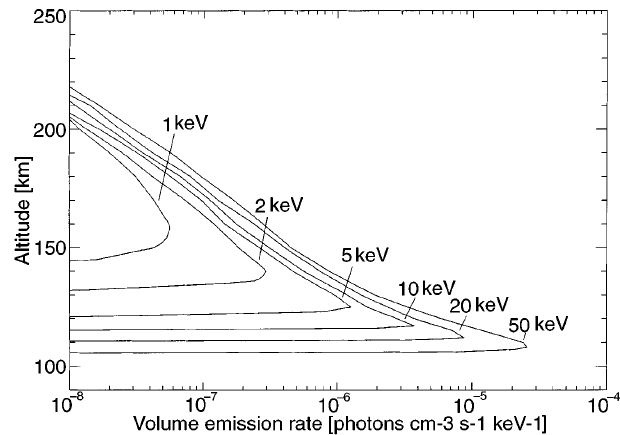
Fig. 4. Volume emission rate versus altitude, for protons with 1, 2, 5, 10, 20 and 50 keV initial energy